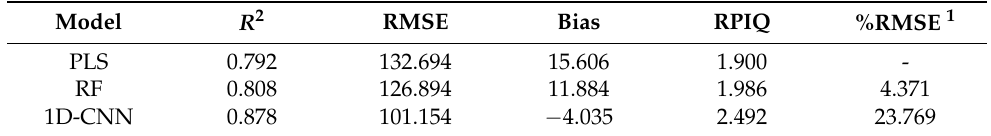
error; RPIQ, ratio of performance to the interquartile range.